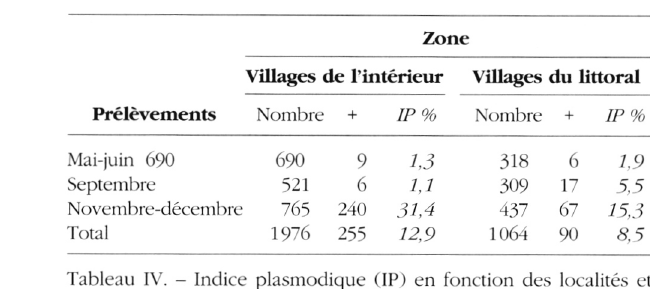
des saison des pluies (novembre-décembre) et plus faible en début de saison sèche (tableau